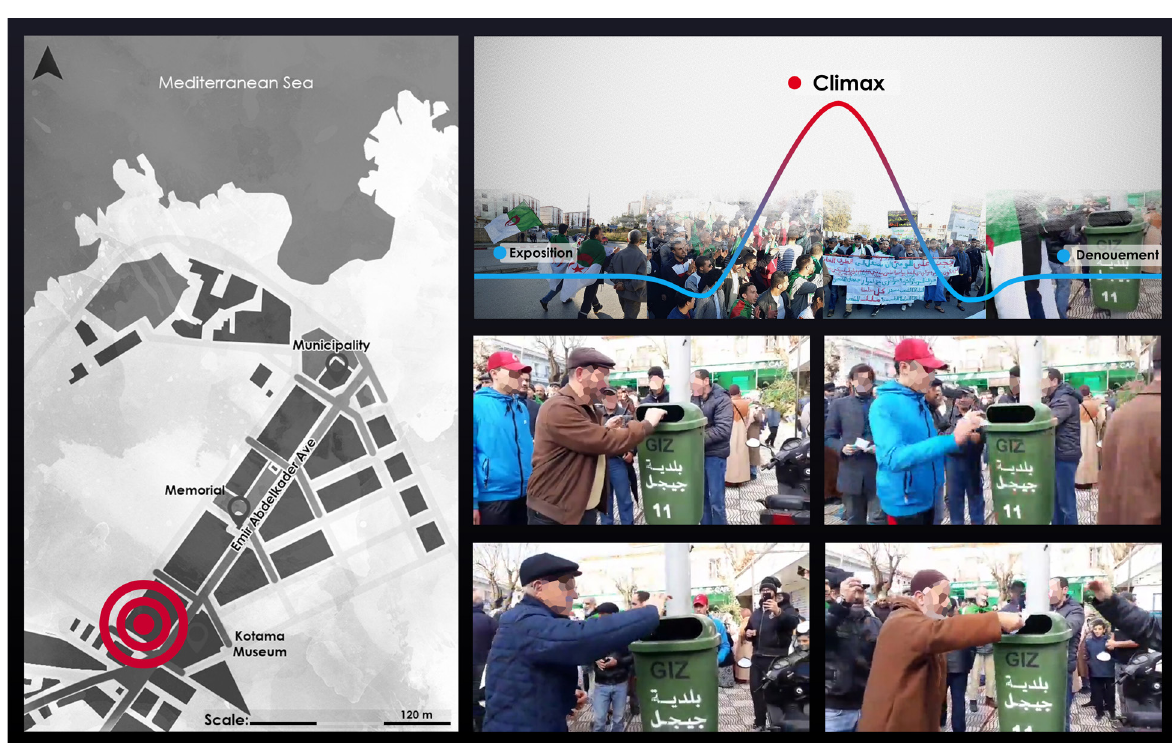
Fig. 2. Few stage captures of urban theatricality of November 12th, 2019 – Emir Abdelkader avenue, accompanied by their evolutions in scenes – from exposition to